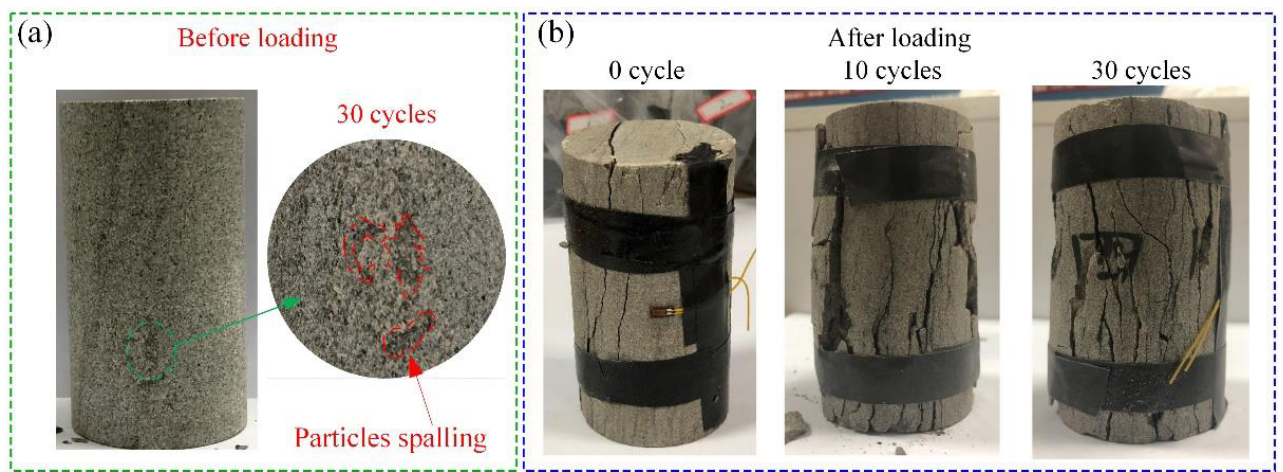
Figure 5. Failure patterns of the tested sandstone that was subjected to different numbers of F-T cycles. ( a ) Before loading; ( b ) After